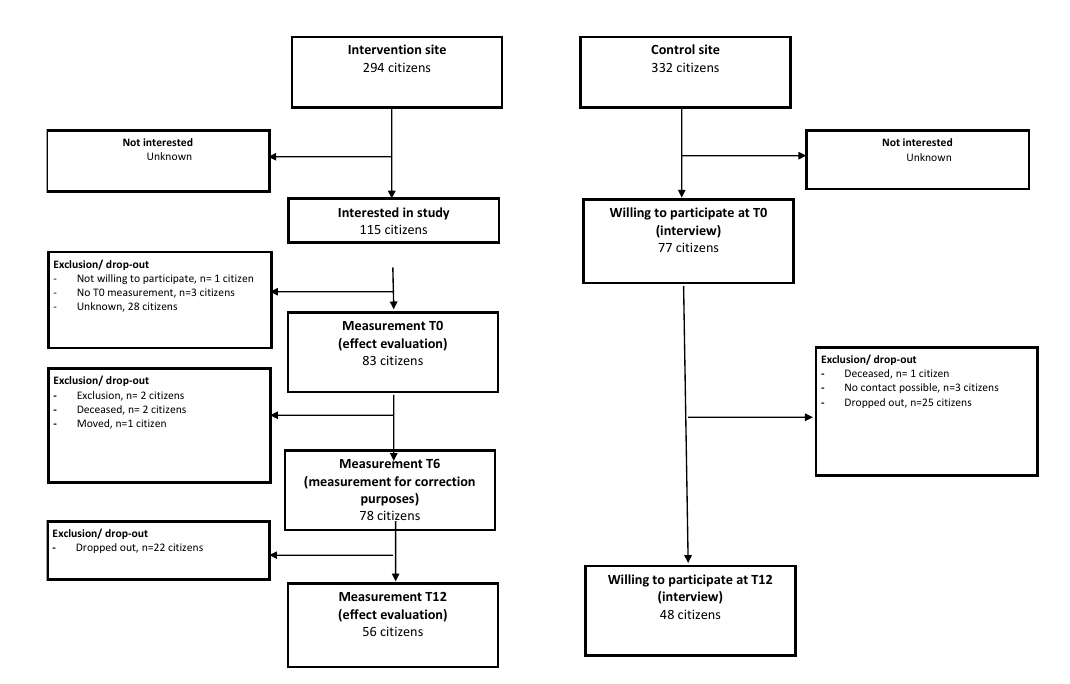
Figure A1. Flow chart inclusion.